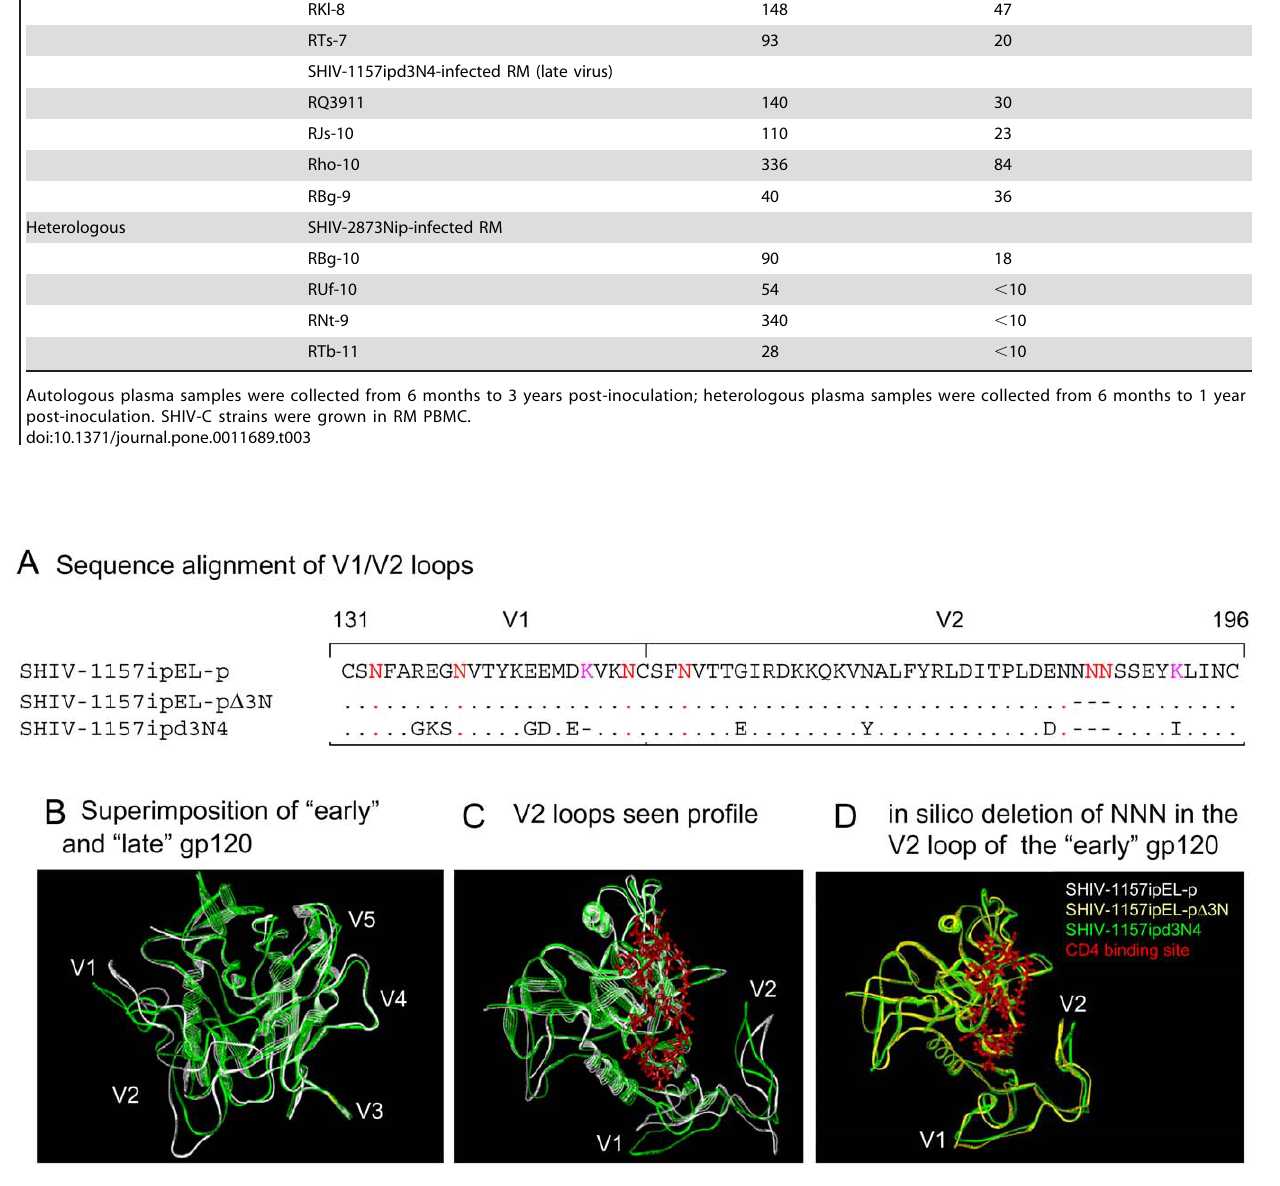
R5 SHIV strain harbored by rhesus Plasma monkeys (RM) and animal name Titers (serum/plasma dilution at 50% neutralization)